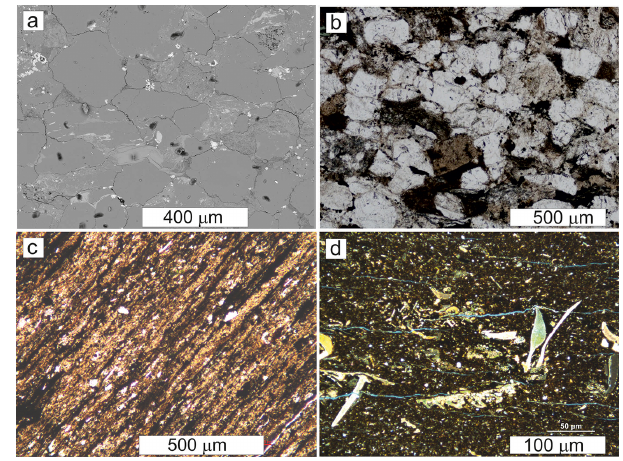
Figure 1. Microstructures of the rocks tested. (a) Back-scattered electron (BSE) image and (b) optical image (plane-polarized light, PPL) of Pennant sandstone, bedding trace parallel to long side of image, showing large quartz grains (mid-grey in a ) with sutured contacts caused by pressure solution and remaining pore spaces largely filled by iron hydroxide (white in a ) and authigenic clay minerals (light grey in a ), reducing the overall porosity to 4.6%. (c) Microstructure (PPL image of polished thin section) of Bowland shale, finely and homogeneously banded with elongate clusters of organic material and pyrite (black) and silt-sized grains of quartz in a matrix of elongate clusters of phyllosilicate (clay and detrital micas) grains. (d) Microstructure of Haynesville shale. (PPL image of polished thin section; long side of image is parallel to layering.) Bioturbation destroys continuity of layering. Rock is only weakly banded but nevertheless fissile; bedding-parallel cracks can be seen, opened during thin-section preparation. Calcareous fossil fragments and authigenic calcite-filled voids, in matrix of finer-grained phyl- losilicate (clays and detrital micas) and fine silt-sized framework